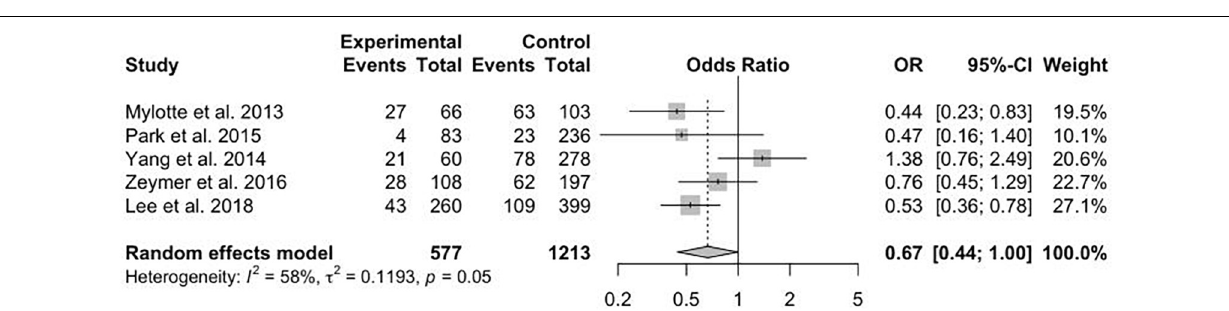
FIGURE 4 | Cardiac death with multivessel (MV) vs. culprit vessel-only (CO) percutaneous coronary intervention (PCI) in patients with ST-segment elevation myocardial infarction (STEMI) complicated by cardiogenic shock